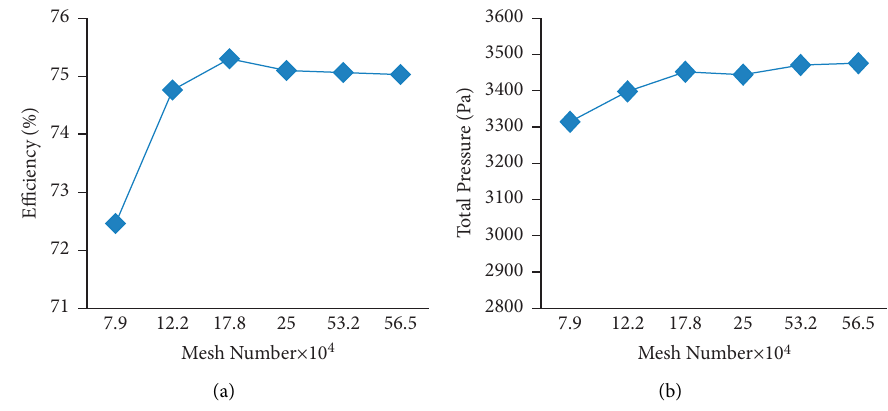
Figure 6: Grid independent calculation: (a) efciency and (b) total pressure. Table 2: CFD calculation parameter setting.